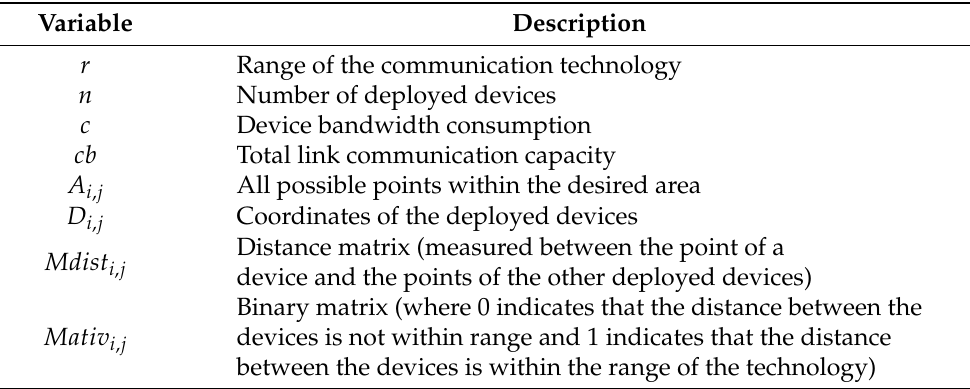
Table 3. The variables that were used for the LP optimization model, including the input parameters and data that were generated from the input